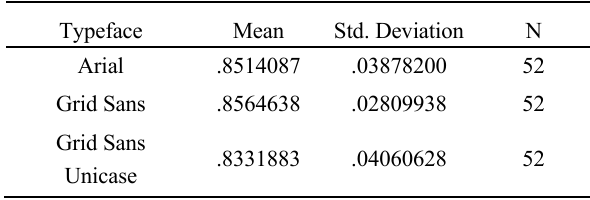
Table 2. Descriptive statistics of SSIM to